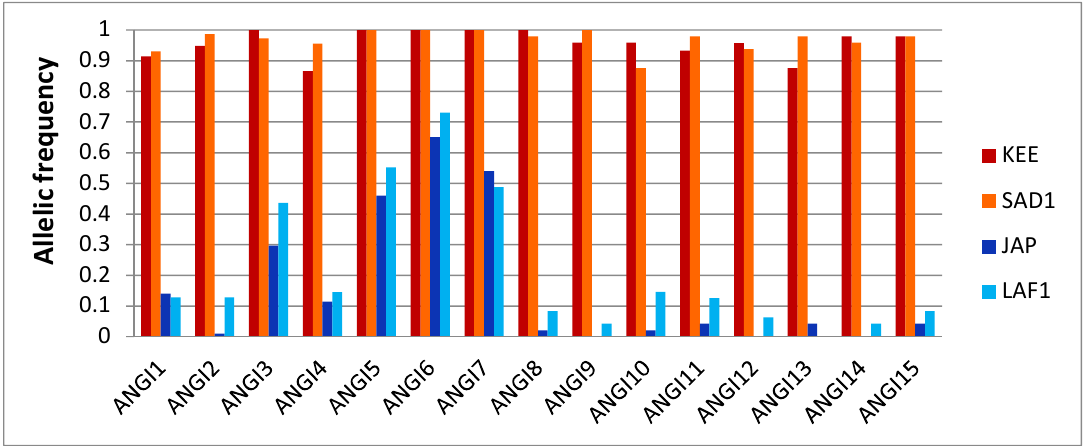
Figure 2. Allelic frequencies of the 15 single-nucleotide polymorphisms (SNPs) at the four native and introduced populations of C. gigas (in blue) and C. angulata (in